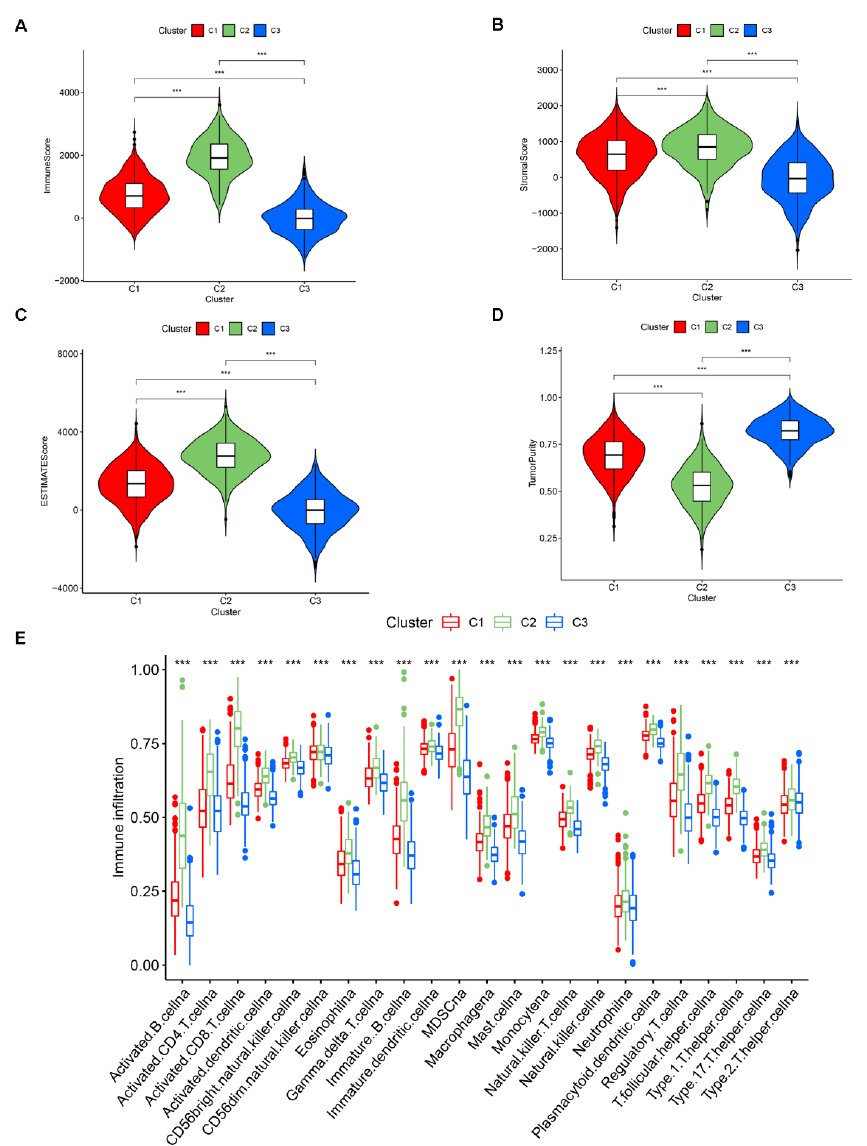
Figure 3. Different phenotypes of BC subtypes in TCGA. ( A – D ) The levels of immune cell infiltration, stromal score, ESTIMATE score, and tumor purity were compared among BC subtypes of TCGA. ( E ) Comparison of the expression levels of 23 kinds of immune cells between BC subtypes in TCGA. p < 0.001 =